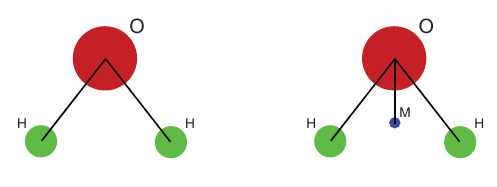
Figure 1. Sketches of TIP3P (left) and TIP4P / 2005